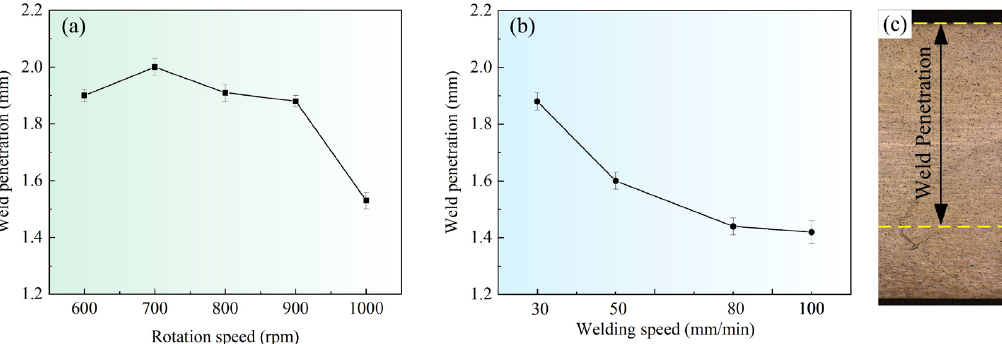
Figure 13. Weld penetration: ( a ) variation with rotation speeds, v = 30 mm/min; ( b ) variation with welding speeds, ω = 900 rpm; ( c ) schematic of the weld penetration measurement; ( d = 12 mm).